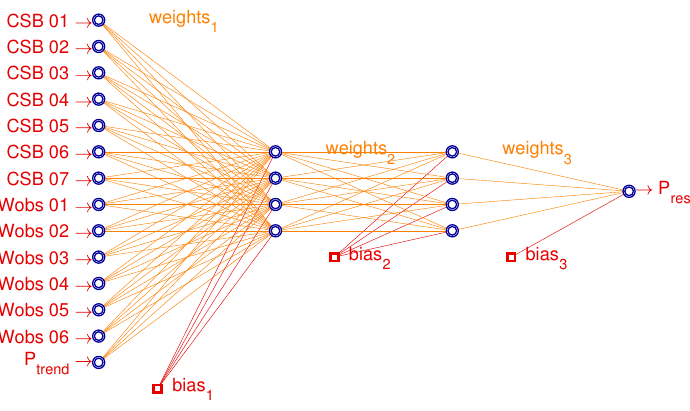
Figure 8. Residual ANN structure for the hybrid approach of plant